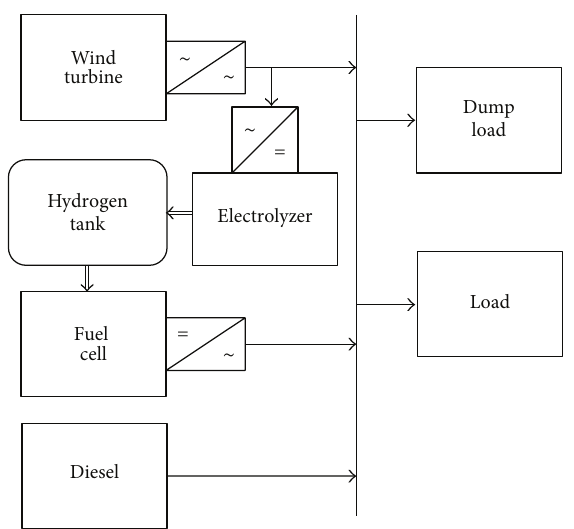
Figure 3: Wind/diesel/hydrogen